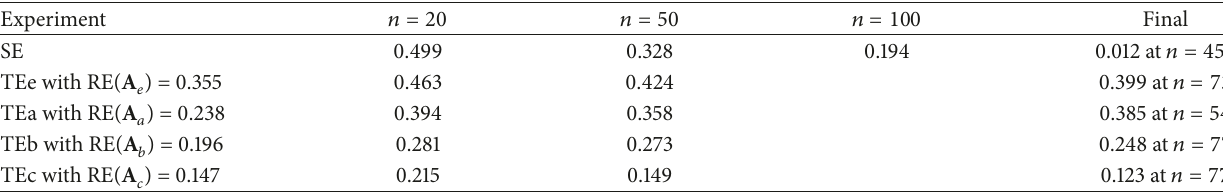
Table 3: As in Table 2 but for the third set of innovations without periodic